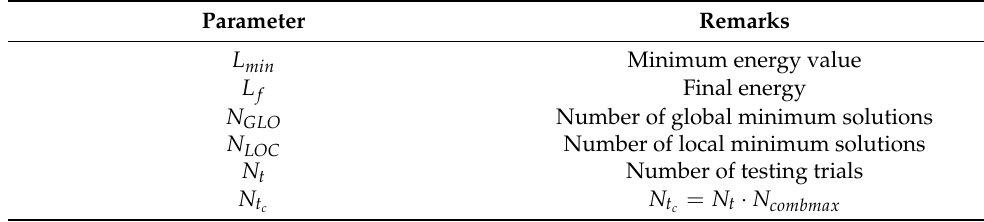
Table 3. List of parameters in the retrieval phase.